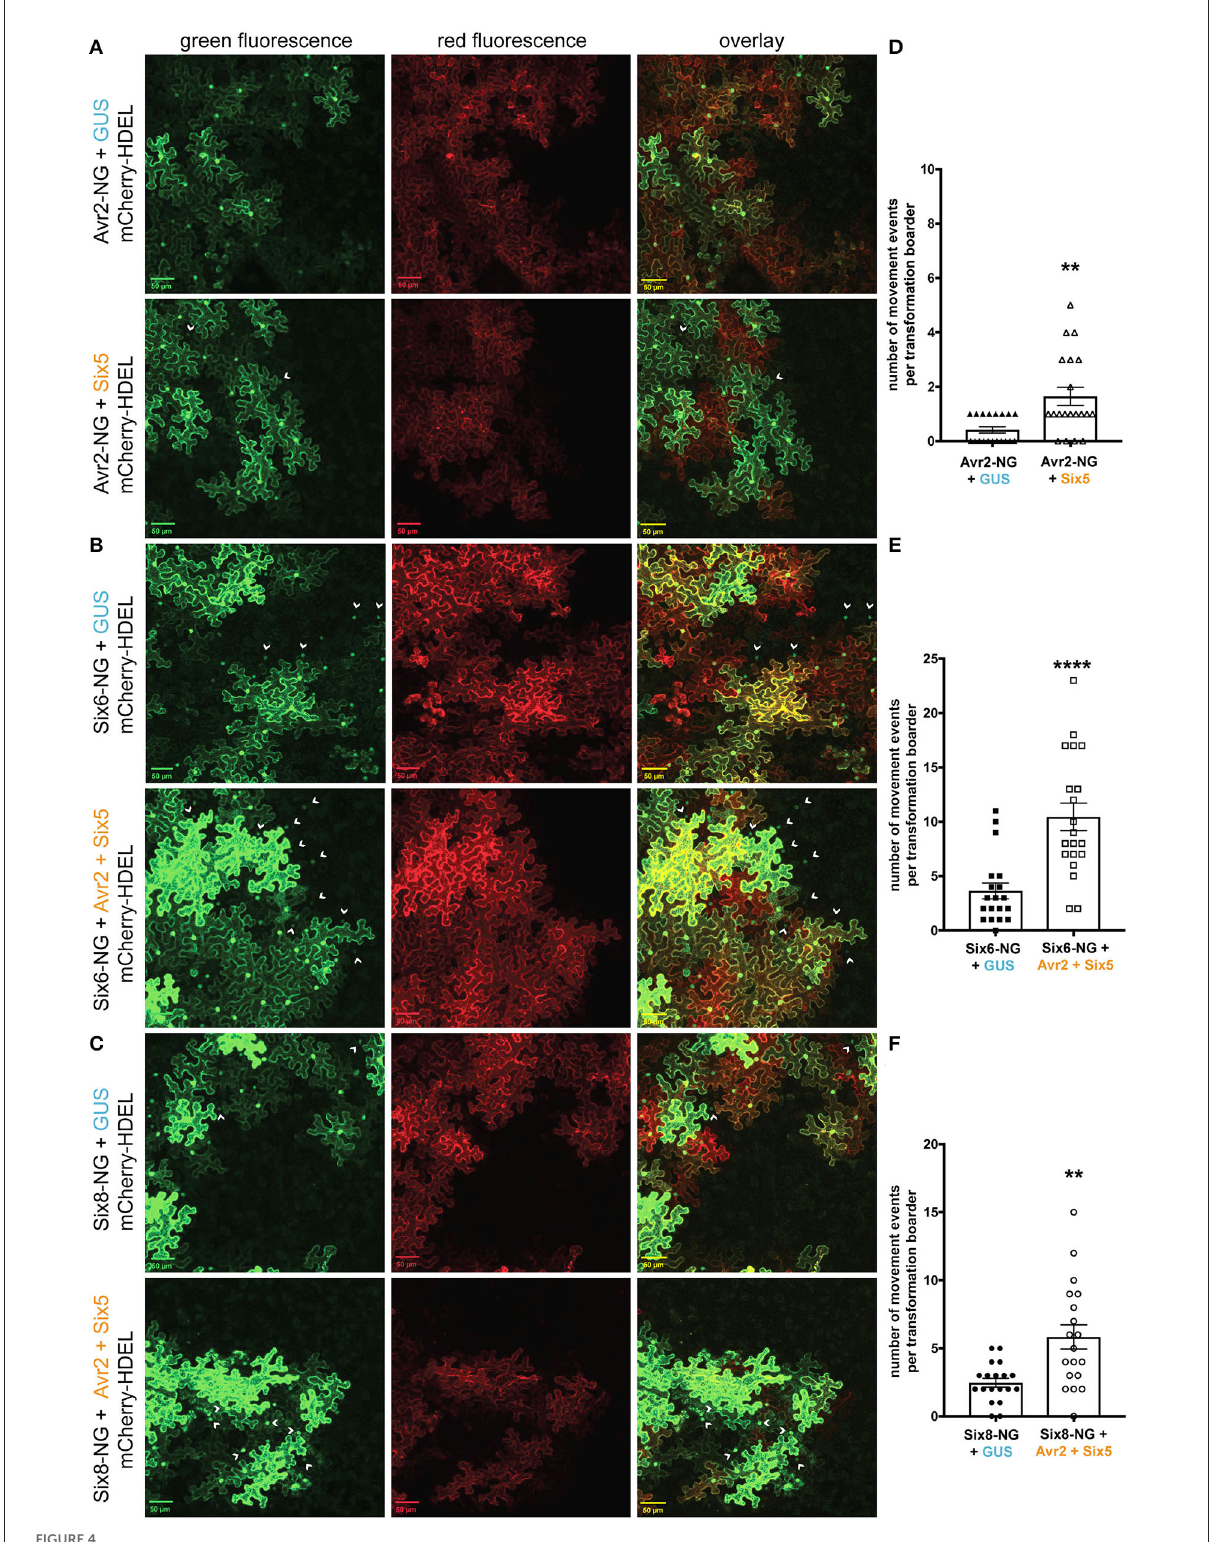
FIGURE4 The Avr2/Six5 effector pair facilitate the movement of Fusarium effectors proteins, Six6 and Six8. (A–C) Co-infiltration of A. tumefaciens strains carrying a binary vector encoding mCherry-HDEL and either Avr2-NG, Six6-NG, or Six8-NG together with a strains expressing either 35S : 1 spAVR2 / 35S: 1 spSIX5 or 35S:GUS into N . benthamiana leaves. Fluorescence was analyzed 72h post-infiltration using confocal